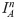
Texture generation.Each photograph (A and B) generates texture atlas (IA and IB). We stitch two textures with indistinct seam to obtain one texture (IC). To obtain clearer texture, we consider both texture color and projected normal direction (IAn and IBn).ICm visualizes used texture with different color (red for A and green for B).